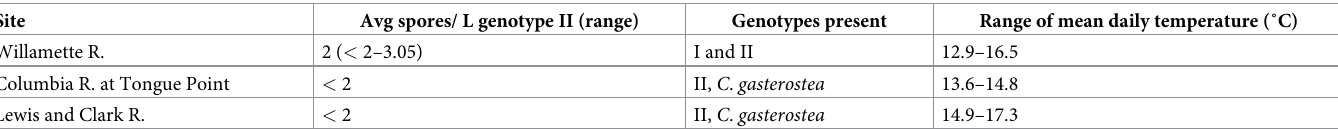
Table 6. Average density (spores/ L) and range of Ceratonova shasta genotype II from three water samples, genotypes present (0, I, II, or C . gasterostea ), and range of mean daily temperatures (˚C) at sentinel sites on the Willamette River, Tongue Point (Columbia River) and the Lewis and Clark River in the Columbia Basin, May 1- May 8, 2019. Site Willamette